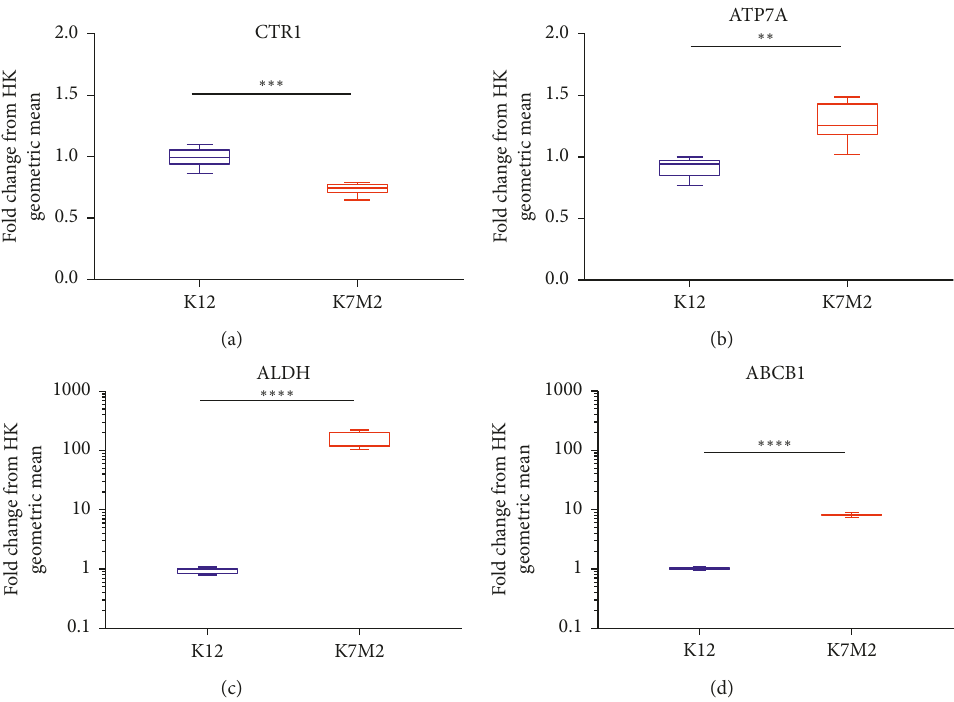
Figure 2: K7M2 displays altered expression of copper influx and efflux pumps as well as important chemoresistance factors compared to K12. K12 and K7M2 OS cell lines grown under identical culture conditions were processed for RNA extraction. cDNA generated was analyzed by qPCR for expression-level alterations between the OS cell lines and normalized to the geometric mean of housekeeper genes Nono, Rps17, and Rps18. (a) The Cu influx pump CTR1 was significantly downregulated in K7M2. (b) The Cu efflux pump ATP7A was significantly upregulated in K7M2 compared with K12. (c) Antioxidant enzyme and known cancer stem cell maker ALDH was significantly upregulated in K7M2 compared with K12 cells. (d) Additionally, the drug resistance multidrug pump ABCB1 was significantly upregulated in K7M2 compared with K12 cells. Molecular analysis was performed using technical triplicates from three separately cultured and processed samples ( n � 9 ) . ∗∗ p < 0 . 005; ∗∗∗ p < 0 . 0005; ∗∗∗∗ p < 0 .